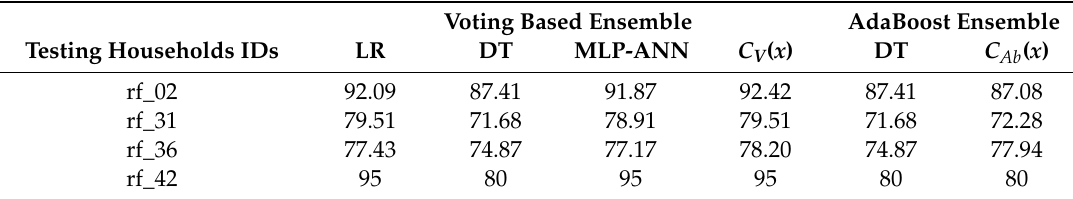
Table 8. Household-level accuracy performance results (%).